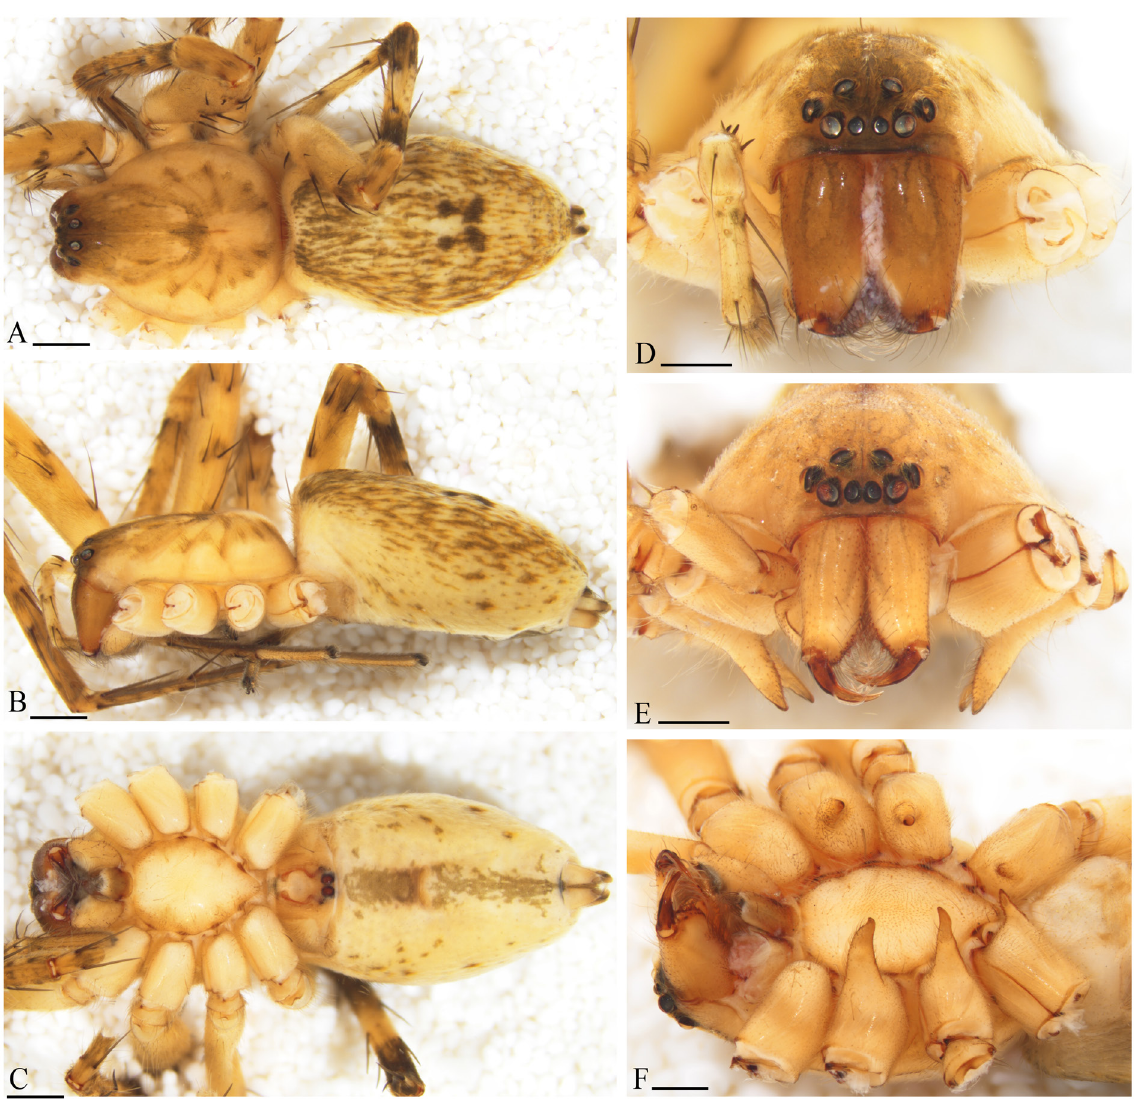
Fig. 25. Anyphaena dulceae sp. nov. A–D . Paratype, ♀ (CNAN-T01553). E–F . Paratype, ♂ (CNAN-T01551). A . Dorsal habitus. B . Lateral habitus. C . Ventral habitus. D . Prosoma, anterior view. E . Prosoma, anterior view. F . Prosoma, oblique view. Scale bars: A–C = 1.0 mm; D–F = 0.5